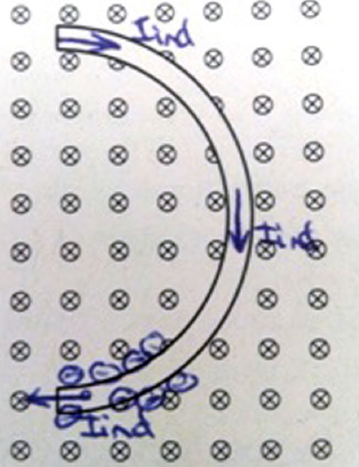
FIG. 8. Drawing of a student (TLS2-1) who correctly answered the half-ring